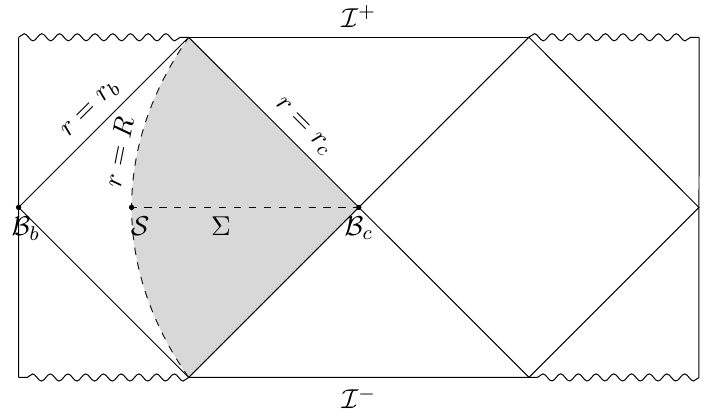
Figure 3 . The Penrose diagram of Schwarzschild-de Sitter spacetime. The York boundary lies at r = R between the black hole and cosmological horizon, and hence defines two distinct thermal systems: the white region between the black hole horizon and the boundary, and the shaded region between the boundary and the cosmological